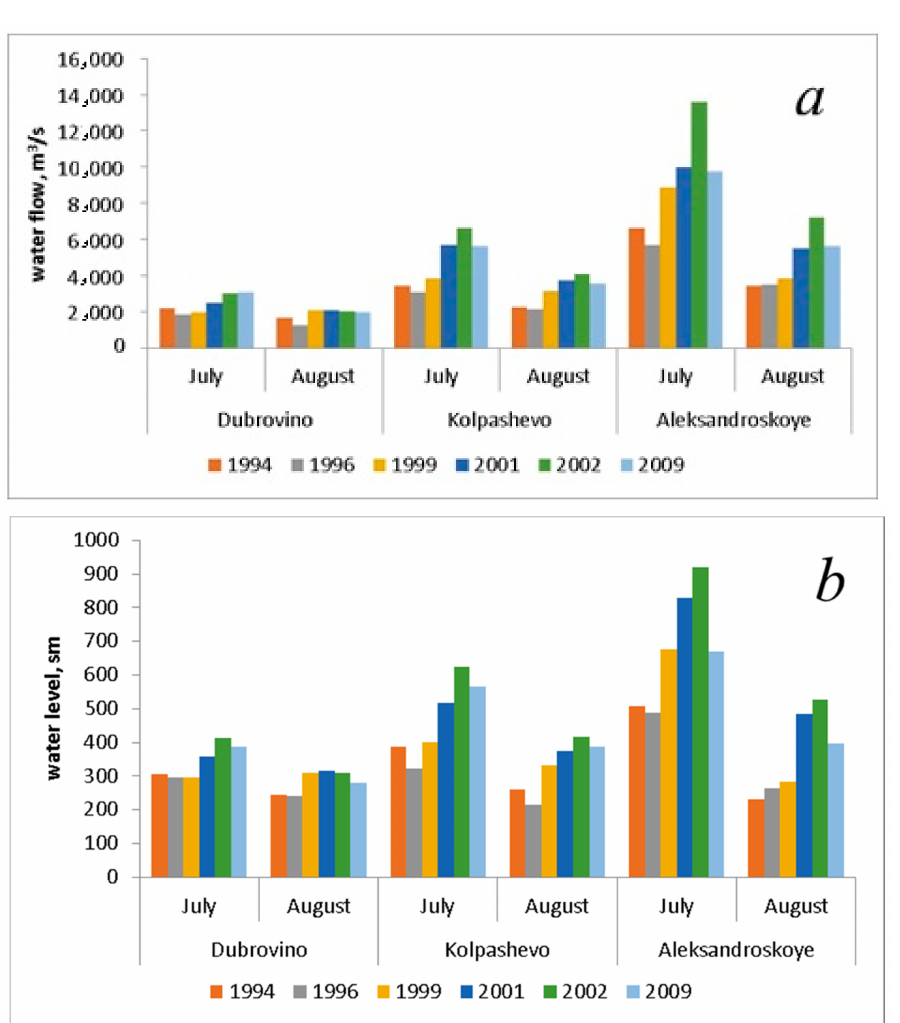
Figure 2. Average monthly discharges ( a ) and water levels above the graph zero ( b ), at sampling